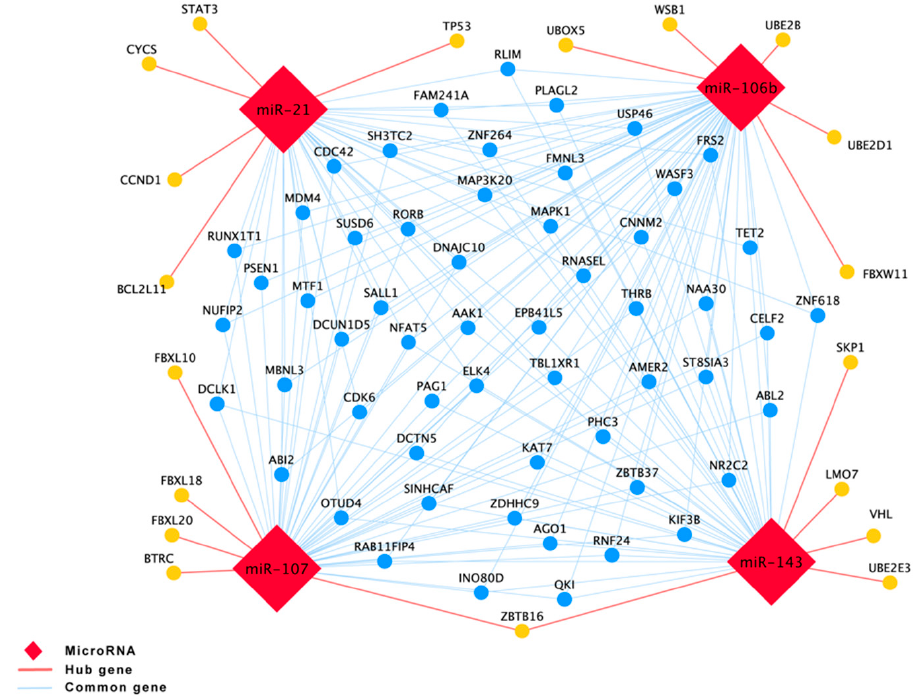
Figure 6. Bioinformatic analysis of targets and pathways of the 4 miRNAs. The protein–protein interactions of hub targets and the common targets among three and four miRNAs. (Cytoscape 3.7.2, https://cytoscape.org/index.html (accessed on 8 January 2022)).